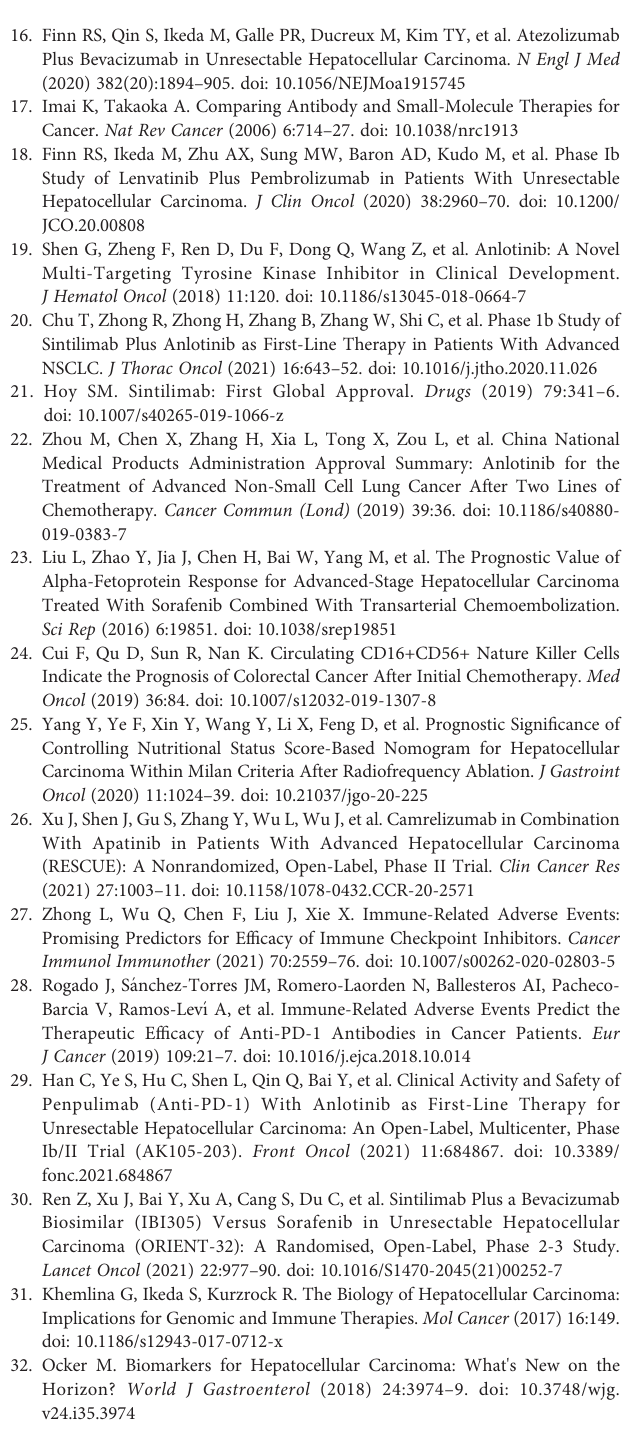
Supplementary Figure 1 | (A) The spider plot presents individual changes in AFP levels over time relative to baseline AFP in the study patients. Patients are coded in different colors. (B) The Kaplan-Meier curves of progression-free survival (PFS) of ef fi cacy-evaluable patients strati fi ed by the presence or absence of AFP response. (C) The Kaplan-Meier curves of PFS of ef fi cacy-evaluable patients strati fi ed by LDH changes between the baseline and the nadir within 9 weeks after treatment.